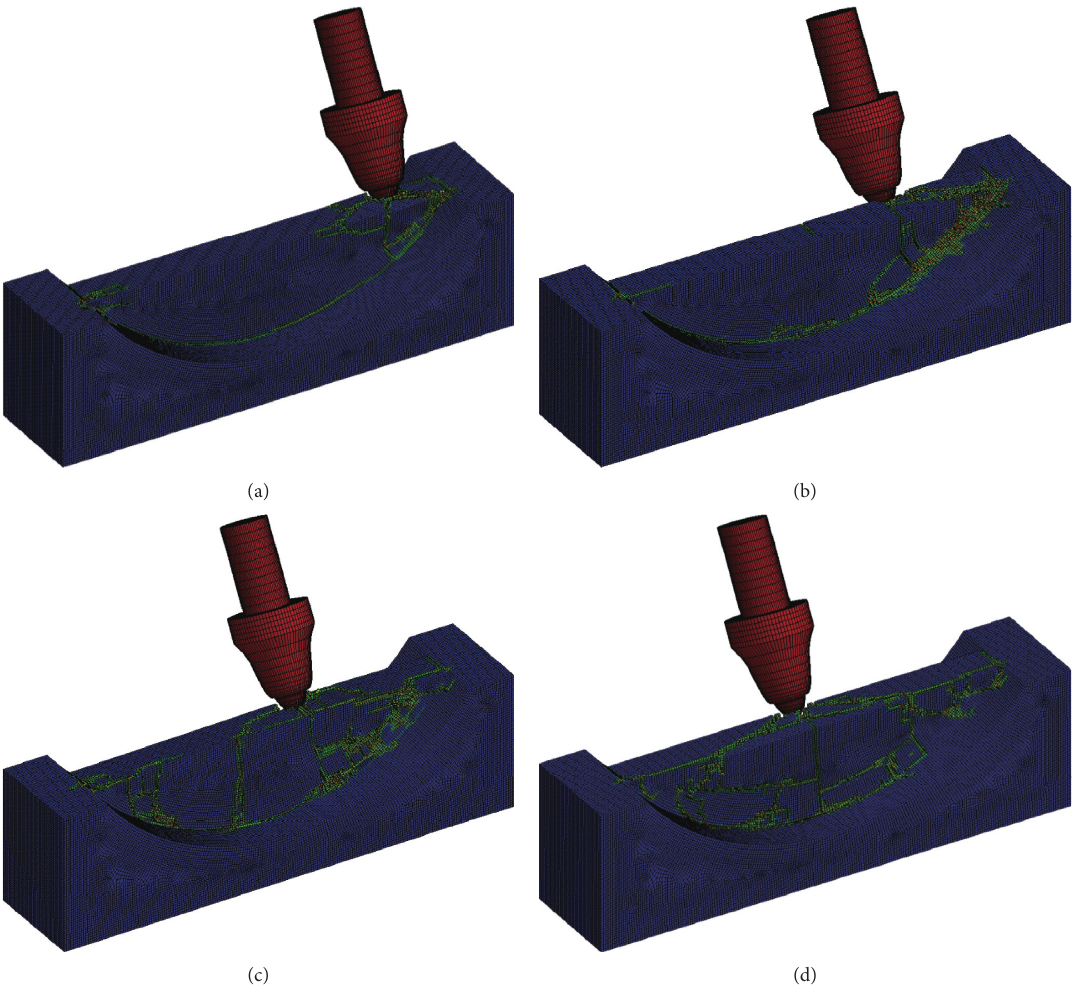
Figure 11: The cutting results of conical pick cutting arc rock plate with different cutting point to arc rock plate central axis distances.